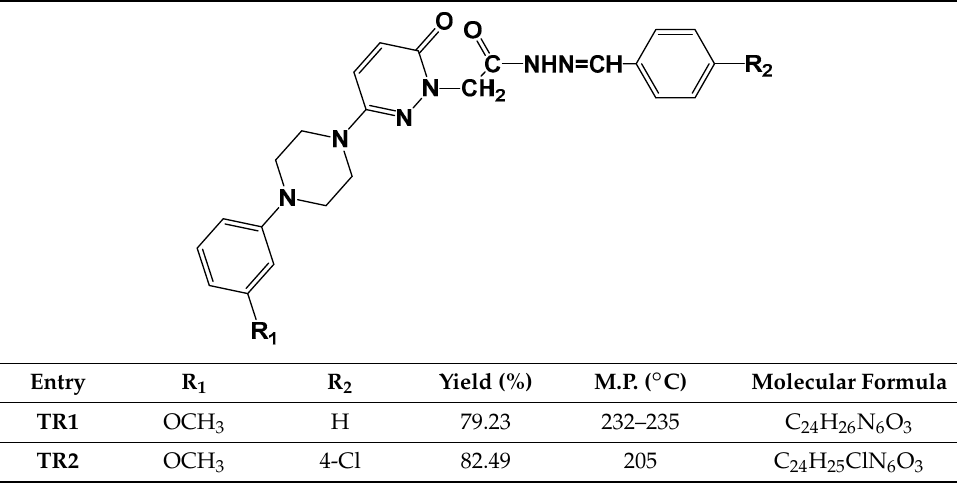
Table 2. Chemical-physical data of titled compounds.